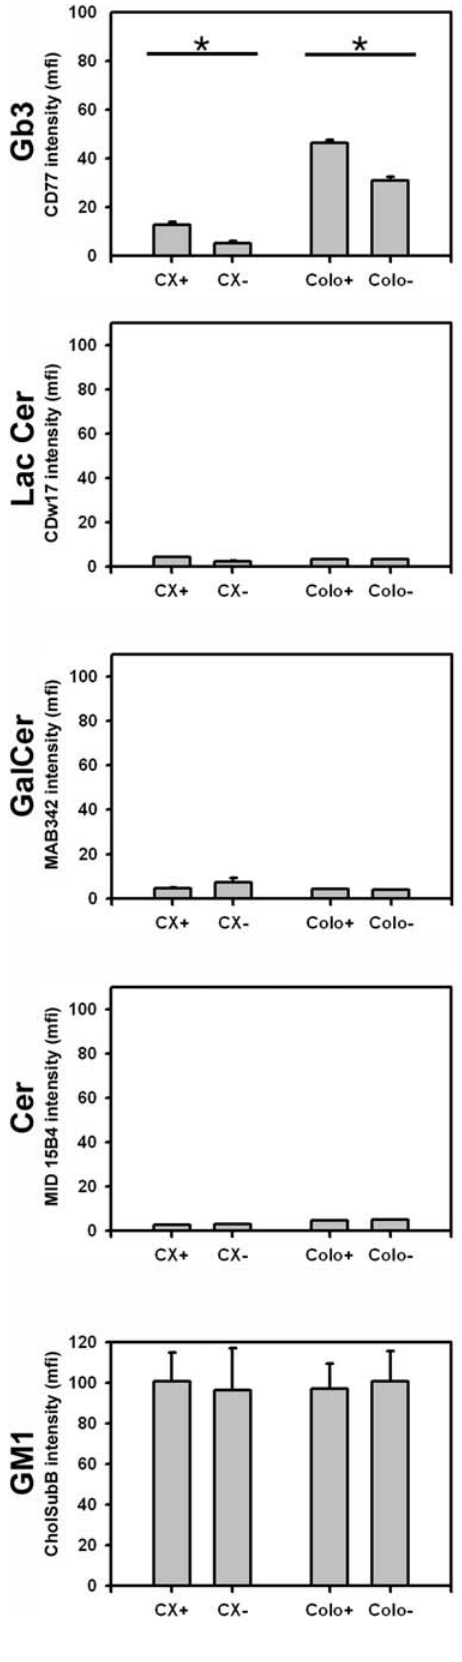
Figure 3. Globotriaosylceramide content is significantly higher in Hsp70 membrane-positive tumor sublines compared to their negative counterparts. Comparative analysis of the cell surface density of glycosphingolipids such as Gb3 (globotriaosylceramide, CD77 Ab), LacCer (lactosylceramide, CDw17 Ab), DoCer (dodecasaccharide- ceramide, CD65s Ab, data not shown), GalCer (galactosylceramide, MAB 342 Ab), Cer (ceramide, MID15B4 Ab), and GM1 (Cholera Toxin subunit B) in CX + /CX 2 and Colo + /Colo 2 tumor sublines. *Indicates values for Hsp70 membrane-positive (CX + , Colo + ) and the corresponding Hsp70 membrane-negative (CX 2 , Colo 2 ) tumor subline that are significantly different (P ,